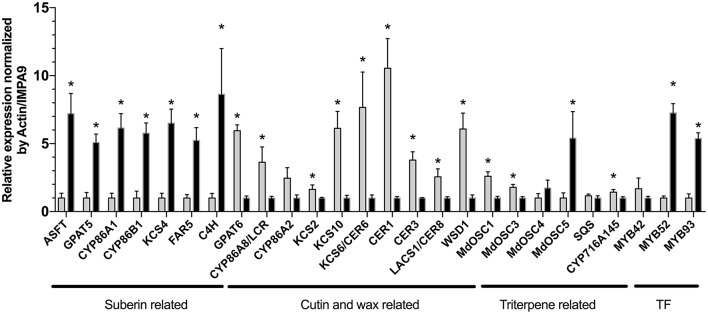
Normalized relative expression (NRq) of lipid surface biosynthesis genes performed in the waxy skin (in gray) and russeted skin (in dark). Relative quantities (Rq) are normalized by Md_Actin and Md_IMPA9 (showed as control (not normalized), NF: normalization factor). *Asterisks highlight genes displaying a statistically significant difference between waxy and russeted “Cox Orange Pippin” skin obtained from a Mann-Whitney test in qbase+ v3 (p < 0.05). Normalized relative quantities were rescaled to the less expressed group (waxy or russet skin) to better visualize fold changes. Error bars display the standard deviation obtained from four biological replicates for each groups. ASFT, Arabidopsis suberin feruloyl transferase-like; GPAT, Glycerol-3-phosphate acyl transferase; CYP, cytochrome P450; “CYP86A1,” fatty acid hydroxylase; “CYP86B1,” very long chain fatty acid hydroxylase; FAR, fatty acid reductase; C4H, cinnamate-4-hydroxylase; CYP86A2, putative fatty acid hydroxylase, CYP86A8/LCR; CER, ECERIFERUM; LACS, long chain acyl-CoA synthetase; KCS, 3-ketoacyl-CoA synthase; WSD1, bifunctional wax ester synthase/diacylglycerol acyltransferase; SQS, Squalene synthase; OSC, oxidosqualene cyclase; CYP716A145, pentacyclic triterpene oxidase; TF, transcription factors; MYB, MYB transcription factor.